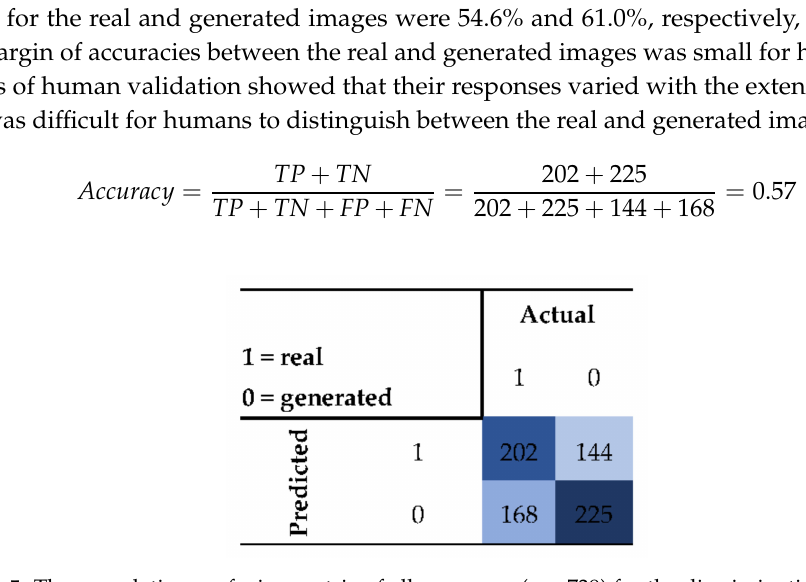
Figure 5. The cumulative confusion matrix of all responses (n = 739) for the discrimination of real and generated ACGAN images